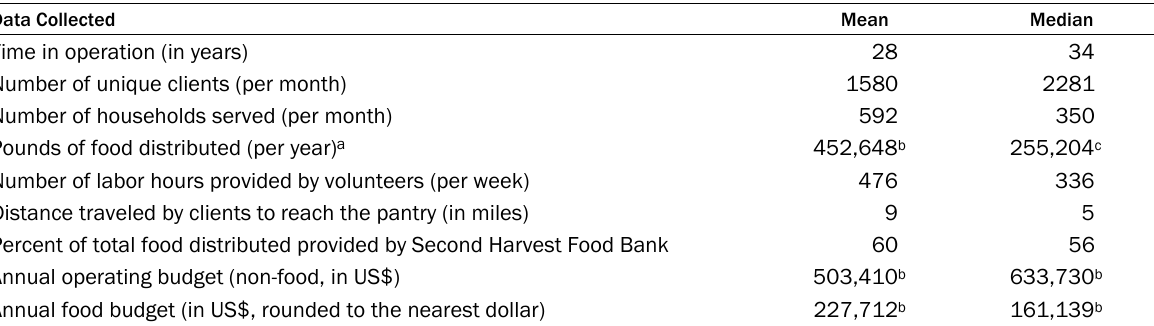
Table 1. Selected Summative Preliminary Quantitative Data from Pilot Survey of Seven Regional Food Pantries in Northwest North Carolina